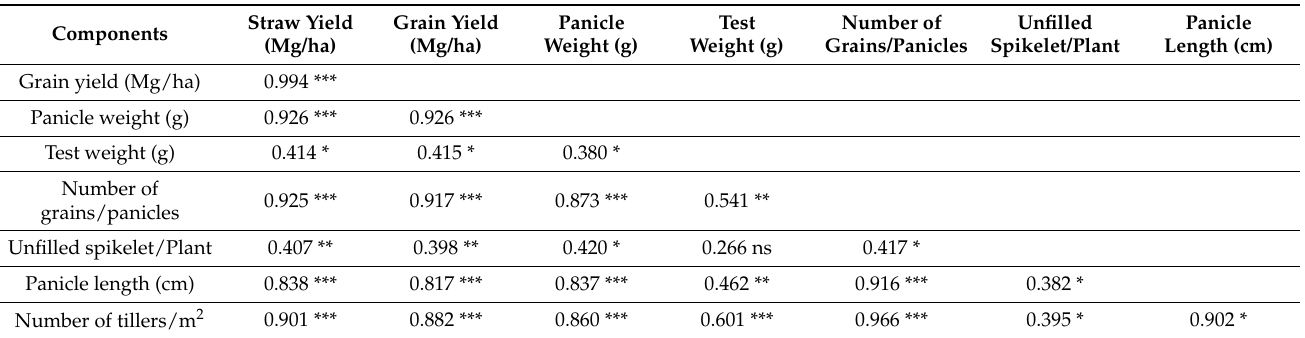
Table 6. Correlations between yield and yield attributes of hybrid